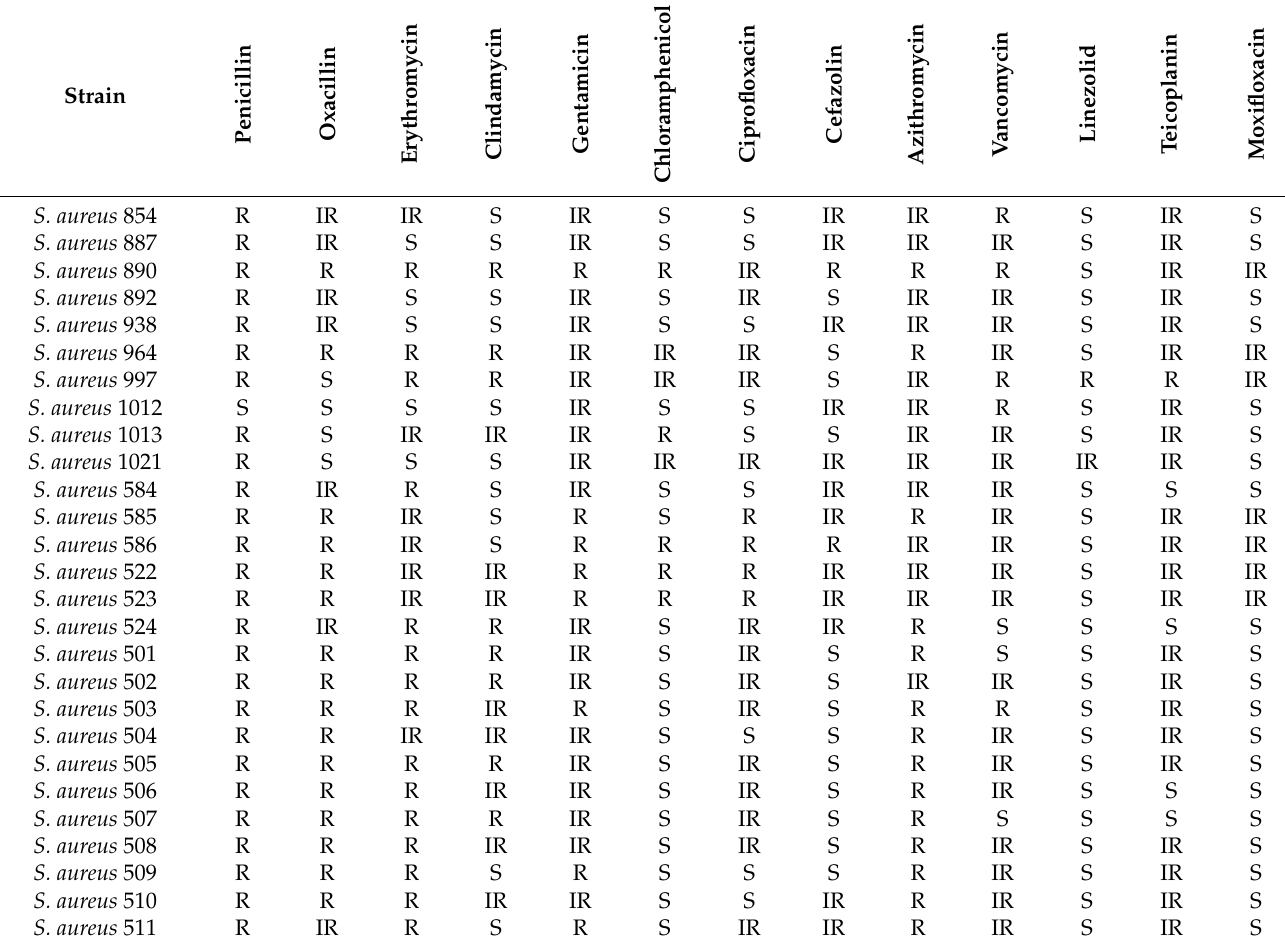
Table 3. The sensitivity of S. aureus strains to